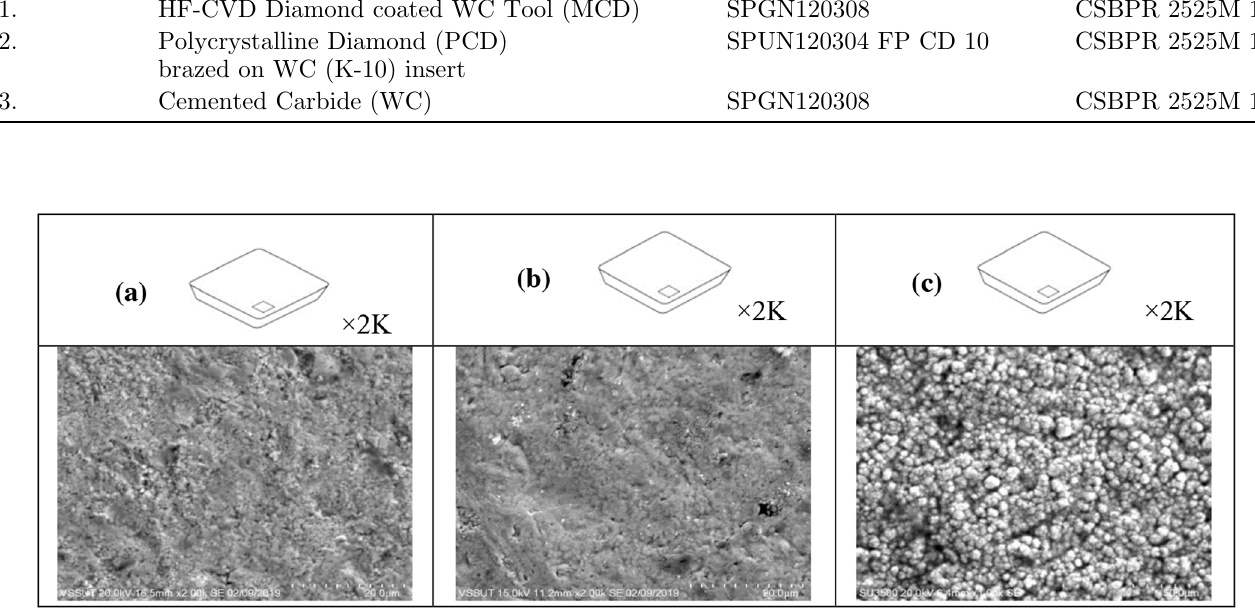
Table 4. Cutting tool materials and tool holder speci fi cation. Sl. No.